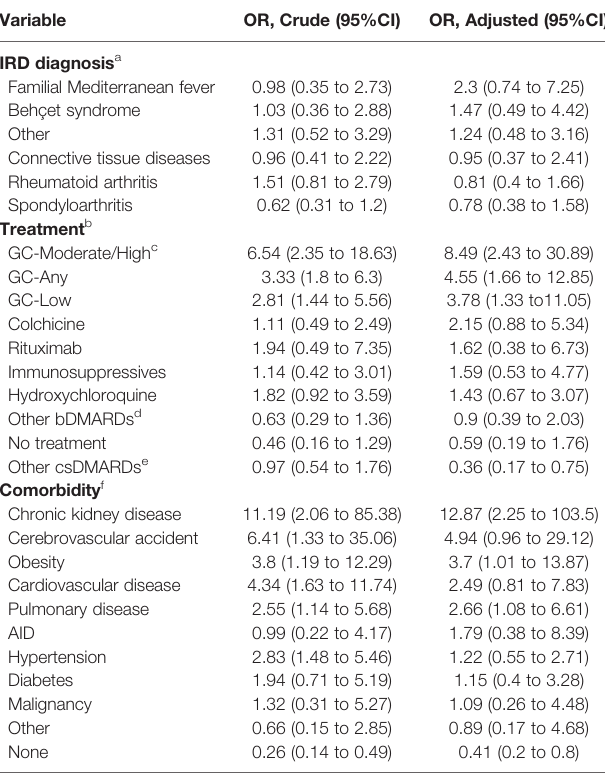
TABLE 3 | Crude and adjusted Odds Ratios of the association of primary IRD diagnosis, IRD treatment, and comorbidity with a worse COVID-19 outcome.